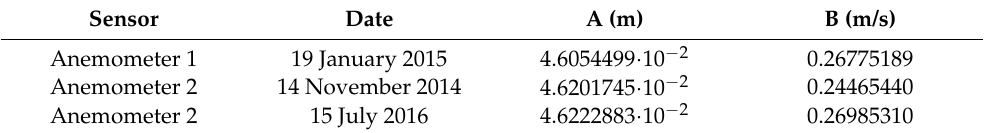
Table 1. CalibrationcoefficientsofAnemometer1andAnemometer2anddateswhentheyweremeasured.